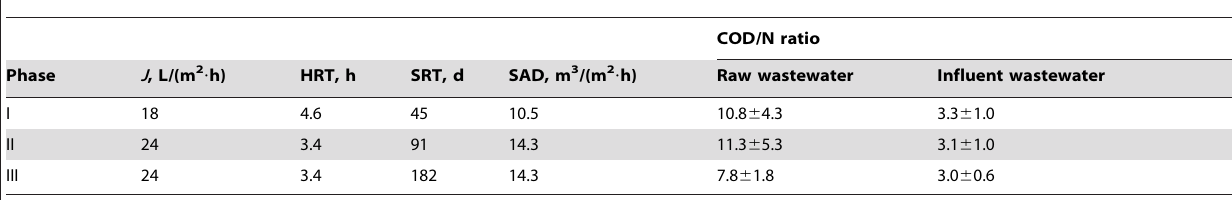
Table 2. Operational conditions of R 0 in three phases.